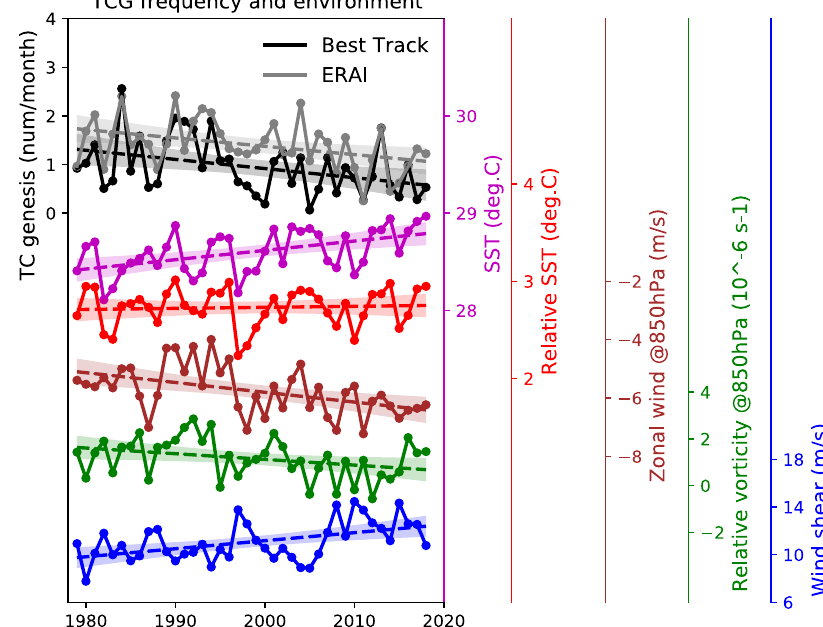
Fig. 6 Changes in late-season tropical cyclone frequency and environmental conditions in the main development region. Timeseries of monthly frequency of TC genesis (TCG) developed in the main development region (MDR, red box in Fig. 5), for the late season (October – December; OND) over 1979 – 2018, in the Best Track ensemble mean (black) and ERA-Interim (grey) TC datasets. Timeseries of sea surface temperatures (SSTs, magenta), relative SSTs (red), 850-hPa zonal wind (brown), 850-hPa relative vorticity (green) and vertical wind shear (blue), averaged over the MDR for the late season over 1979 – 2018, in ERA-Interim. Relative SSTs are SSTs minus the average of global SSTs in 30°S – 30°N. Dashed lines represent the linear trend, with shading showing 95% con fi dence interval for the linear fi t; the El Niño Southern Oscillation and Paci fi c Decadal Oscillation effects are removed by a multivariate Methods Best Track data . TC Best Track observations from three national meteorological agencies — the Joint Typhoon Warning Centre (JTWC), the Japan Meteorological Agency (JMA) and the China Meteorological Administration (CMA) — for 1951 – 2018 are used to synthesise a multi-source ensemble (Best Track ensemble). Best Track observations include the location and intensity (maximum sustained wind speed and minimum sea level pressure) at 6-hourly intervals. As TC track uncertainty is large for weak storms 12 , our analysis of Best Track data only con- siders TCs that reach severe tropical storm intensity (i.e., maximum sustained winds ≥ 48 knots or ≥ 24 m/s). Our Best Track ensemble consists of various TC location metrics (see TC location metrics in the section for details). These TC location metrics are derived for each storm, in every Best Track source, separately, before synthesising the ensemble. The spread of the ensemble re fl ects inter-agency uncertainty in TC estimates. Maximum sustained winds are estimated differently at the three agencies: JTWC uses 1-min mean of maximum sustained winds, while CMA and JMA use 2- and 10-min means, respectively. There is no simple conversion between these wind speeds 14 . The extratropical cyclone stage is included in Best Track, but the years when this began vary among agencies 16 . In our analysis, we divide the Best Track records into the pre-satellite (1951 – 1978) and satellite (1979 – 2018) eras. Caution should be taken with the statistical results for the pre-satellite era. In the pre-satellite era, Best Track data have low reliability due to observation biases 11,22,23 (see the main text). In the pre- satellite era, the JMA Best Track data usually have missing TC intensity estimates, although the categories of storm are provided. This makes it impossible to calculate the location metric of LMI and other related metrics (transit distances of developing and dissipating lifecycle phases). Thus, the Best Track ensemble for these metrics in the pre-satellite era only includes the JTWC and CMA data.